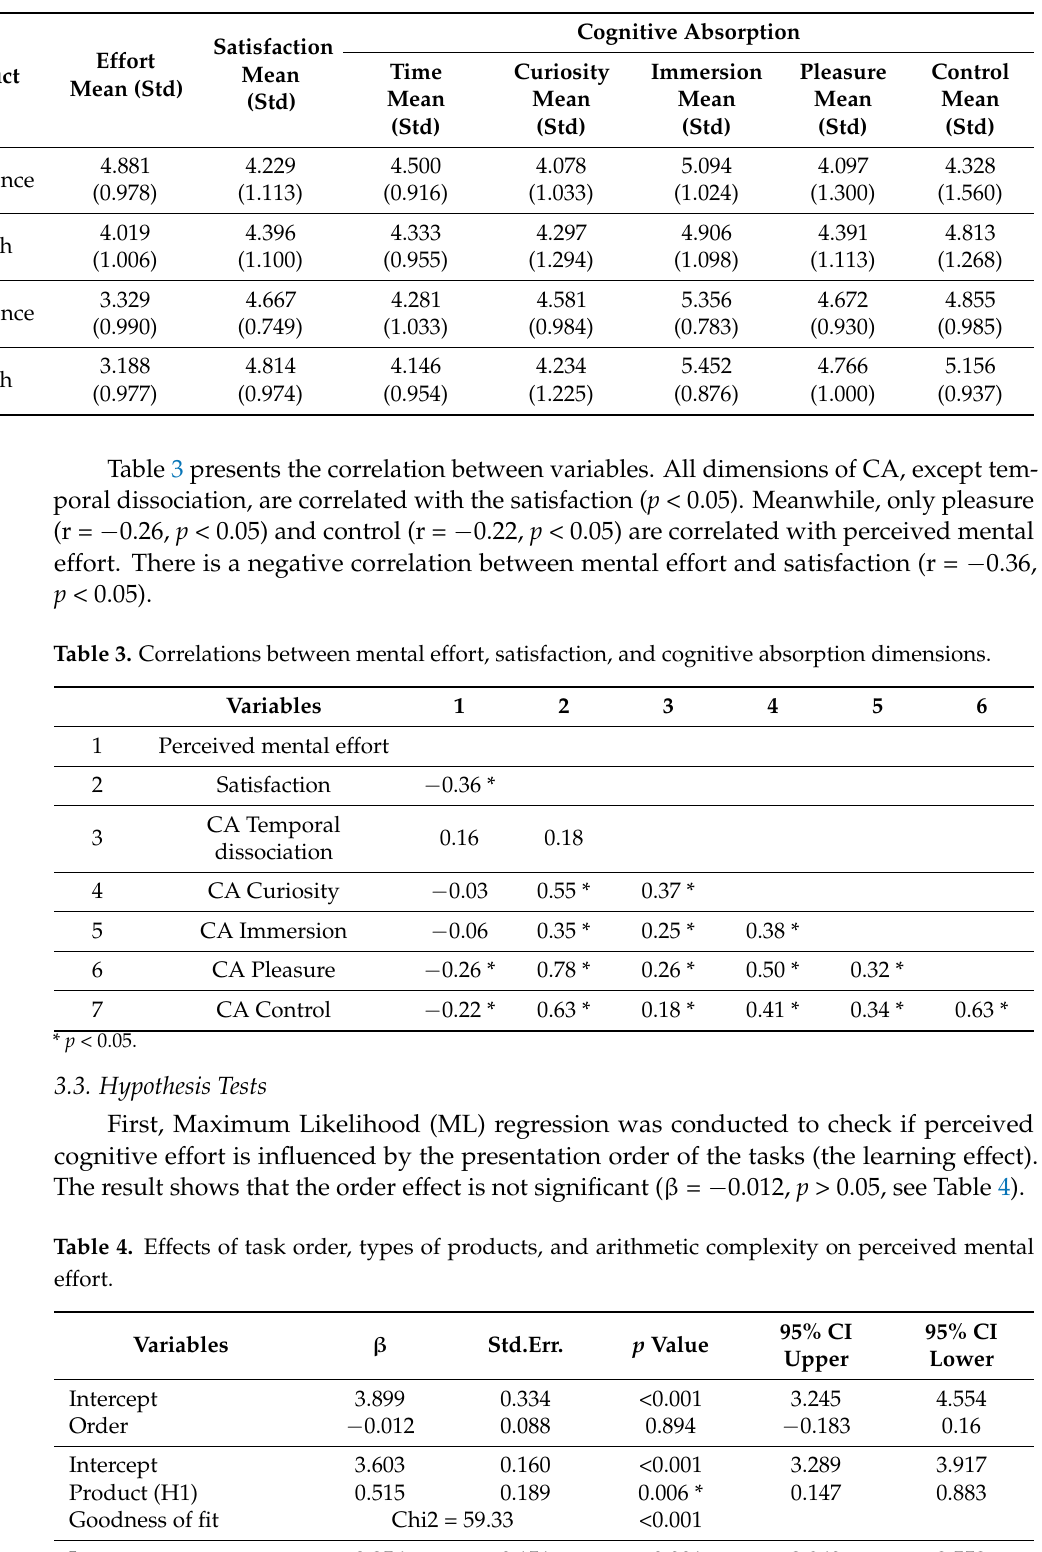
Table 2. Mean and standard deviation of perceived mental effort, e-satisfaction, and cognitive absorption dimensions.